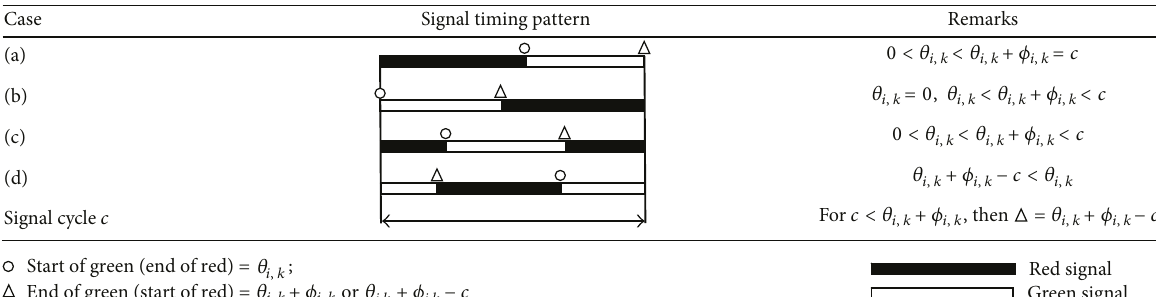
Figure 4: Four different possible patterns to display green and red signals in a signal cycle.